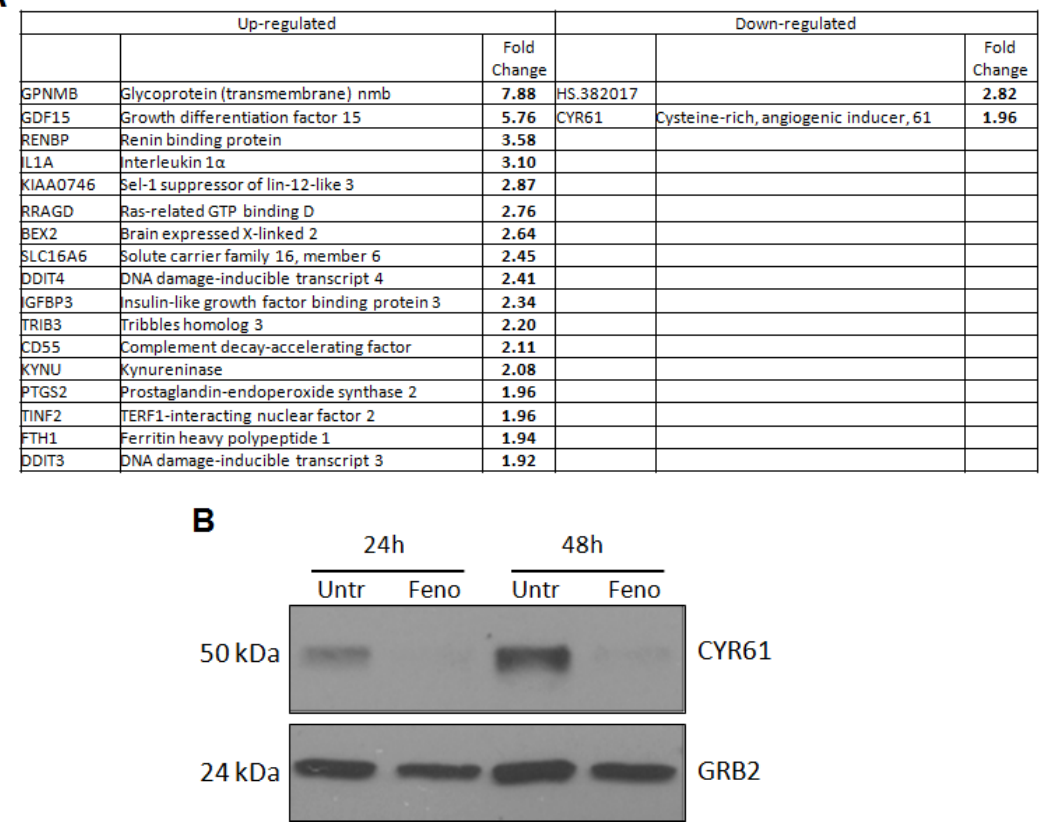
(cid:54)(cid:76)(cid:81)(cid:70)(cid:72)(cid:3) (cid:38)(cid:60)(cid:53)(cid:25)(cid:20)(cid:3) (cid:22)(cid:182)(cid:56)(cid:55)(cid:53)(cid:3) (cid:76)(cid:86)(cid:3) (cid:83)(cid:85)(cid:72)(cid:71)(cid:76)(cid:70)(cid:87)(cid:72)(cid:71)(cid:3) (cid:87)(cid:82)(cid:3) (cid:69)(cid:72)(cid:3) (cid:68)(cid:3) (cid:87)(cid:68)(cid:85)(cid:74)(cid:72)(cid:87)(cid:3) (cid:82)(cid:73)(cid:3) (cid:80)(cid:76)(cid:53) -136, miR-155, and miR-634, we